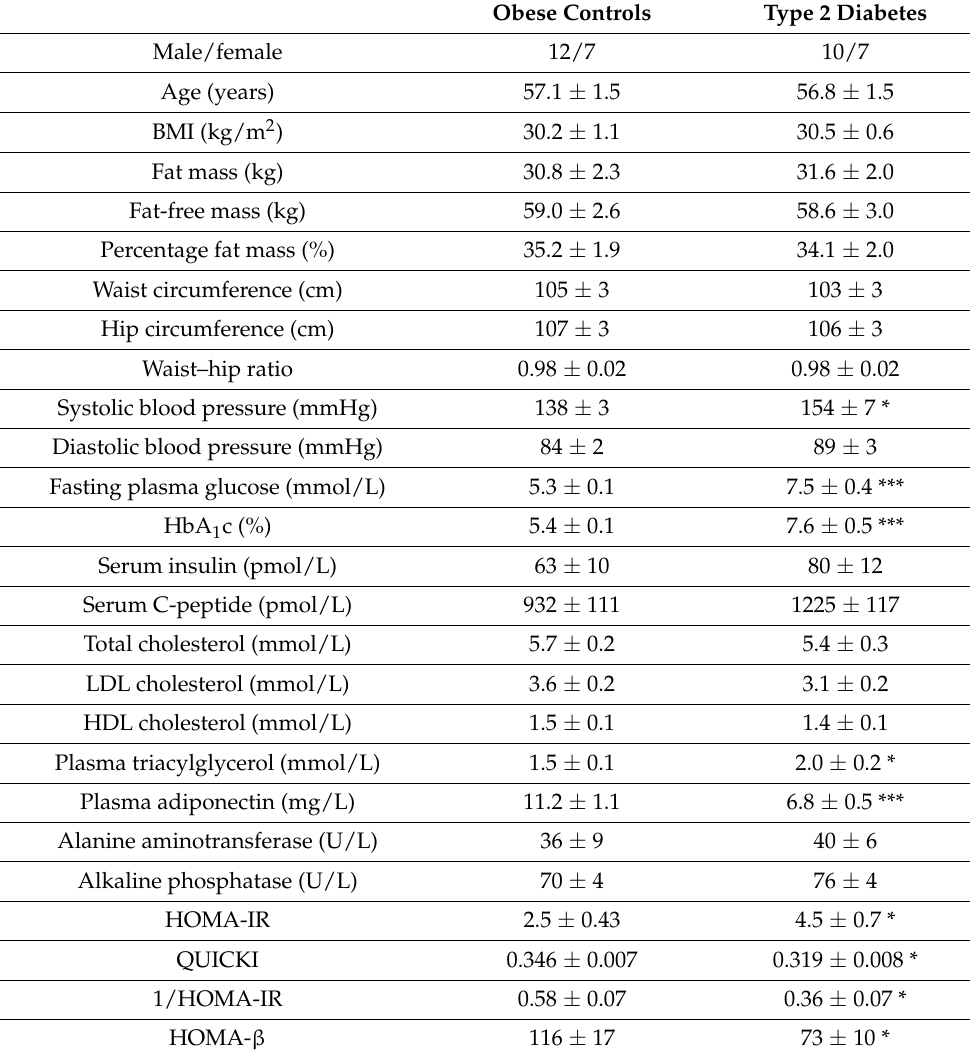
Table 1. Clinical and metabolic